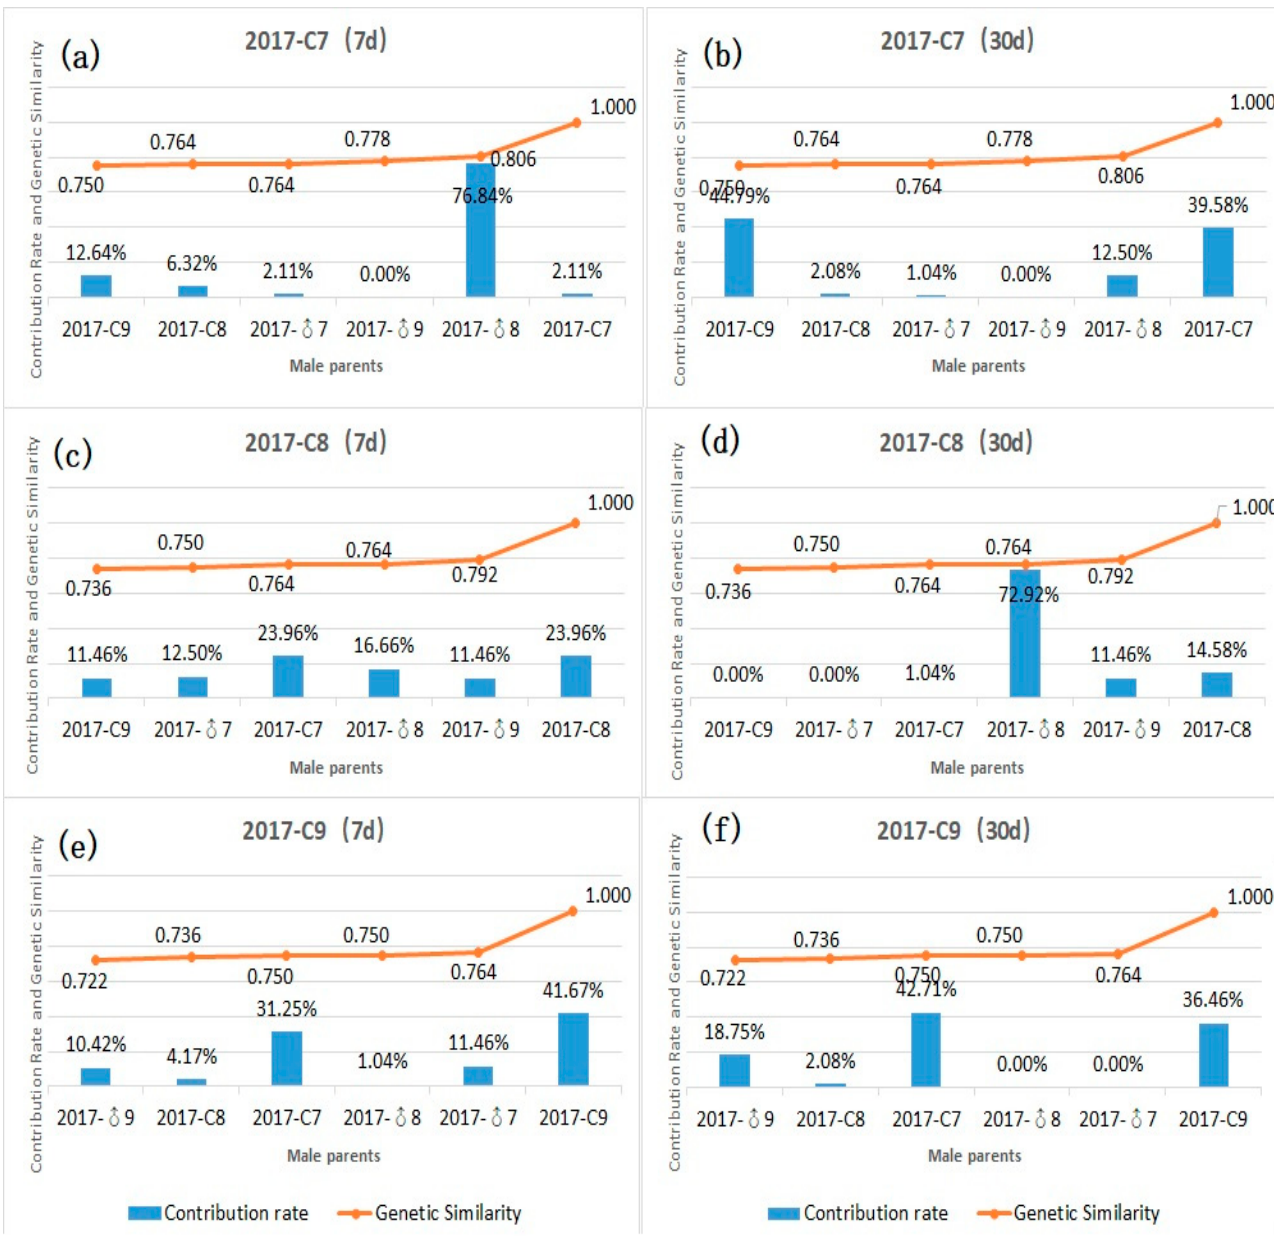
Figure 10. Contribution rate of each male parent and genetic similarity between each male parent and the female parent for the hybrid combinations: ( a ) ♀ 2017-C7, ( c ) ♀ 2017-C8, and ( e ) ♀ 2017-C9 at 7 days after pollination, and ( b ) ♀ 2017-C7, ( d ) ♀ 2017-C8, and ( f ) ♀ 2017-C9 at 30 days after pollination.